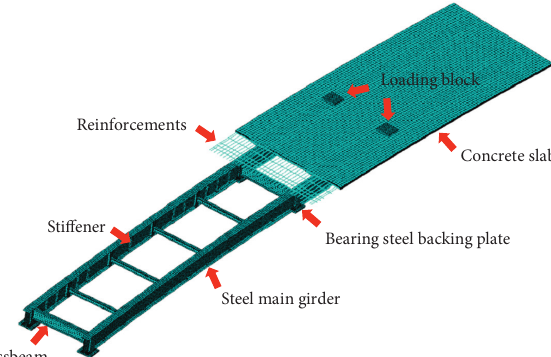
Figure 11: 3D finite element model of the bridge